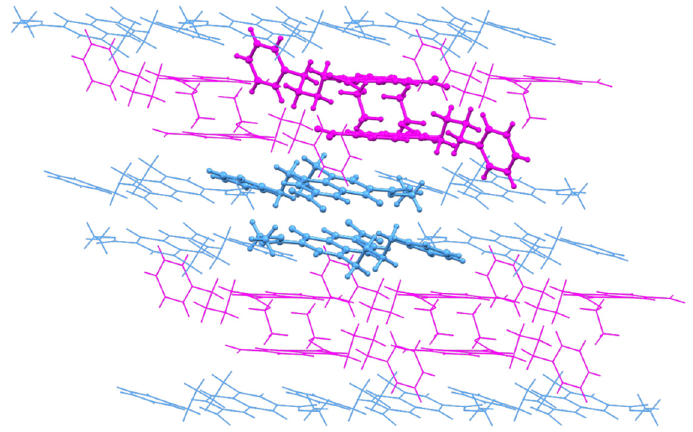
Figure 7. Crystal packing of 4d viewed along the c-axis. Molecules of A are light blue, molecules of B are in magenta. The A … A and B … B dimers are evidenced by ball and stick representation.